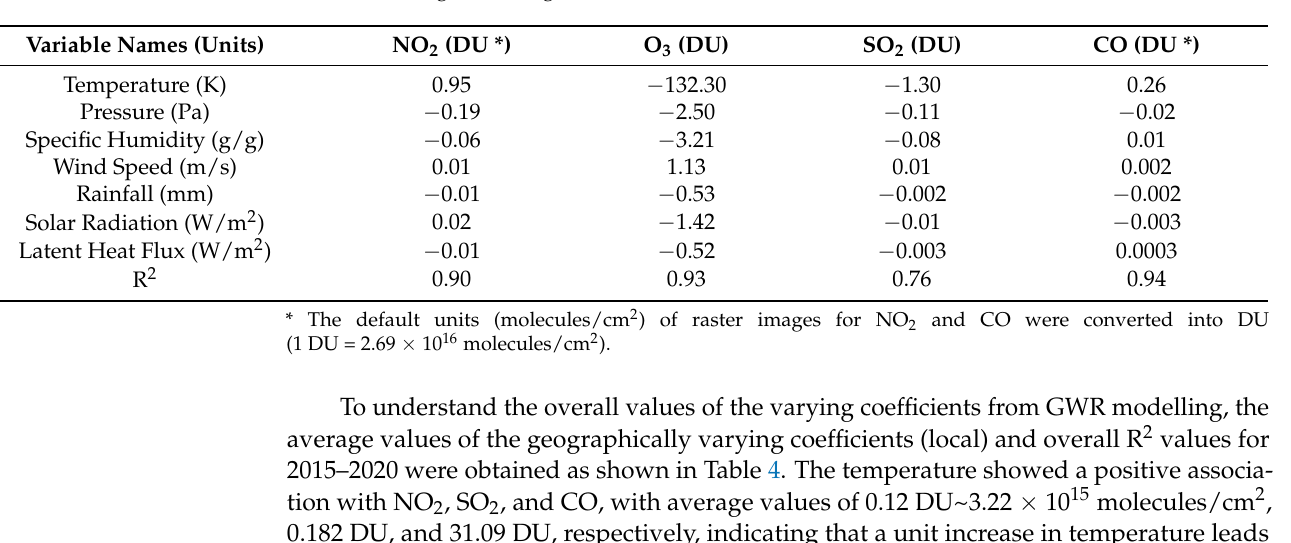
Table 3. Average values of geographically varying coefficients in the study area as obtained from GWR modelling over Bangladesh in